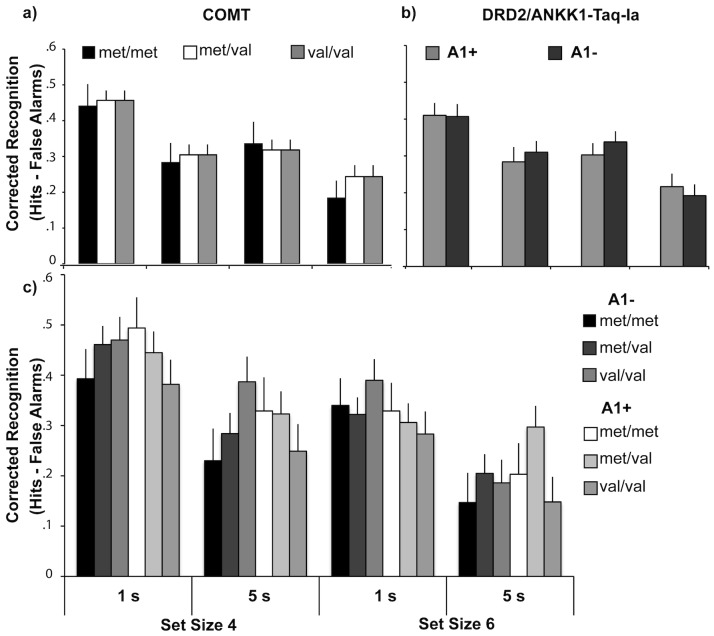
Accuracy findings.
abc) These figures follow the same conventions as in Figure 2 but plot the accuracy (corrected recognition) data.